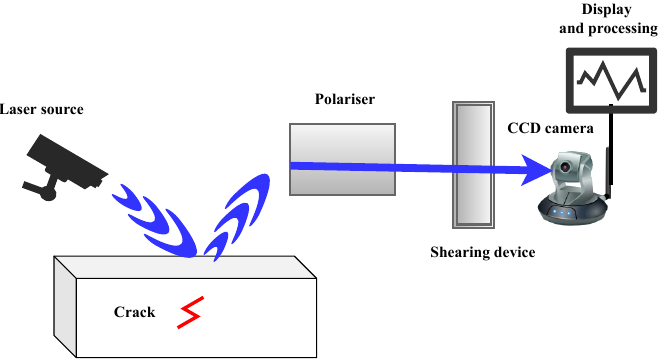
Figure 6. Schematic illustration of a shearography